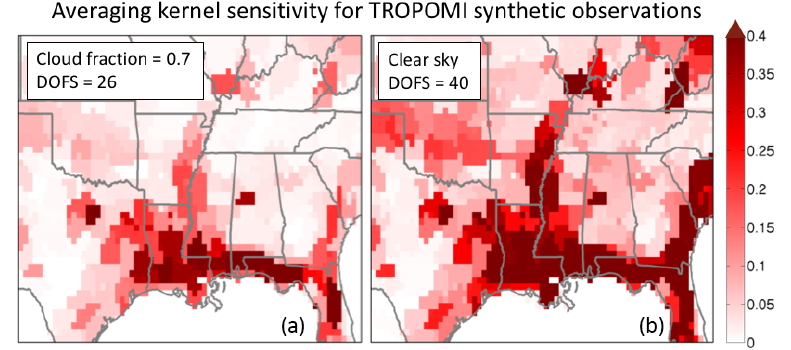
Figure 7. Diagonal elements of the averaging kernel matrix from our OSSE using TROPOMI synthetic observations under cloudy (cloud fraction = 0.7; a ) and clear-sky conditions (b) , representing the ability of the observations to constrain local emissions (see text). The sum of these values (trace of the average kernel matrix) is the DOFS of the